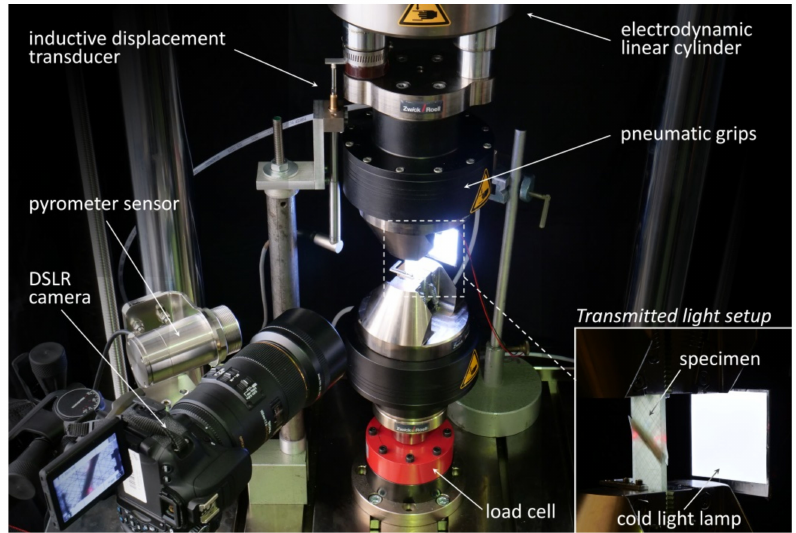
Figure 2. Overview of the experimental set-up: Zwick LTM10 electrodynamic testing machine with an additional transmitted light set-up and pyrometer-based specimen temperature